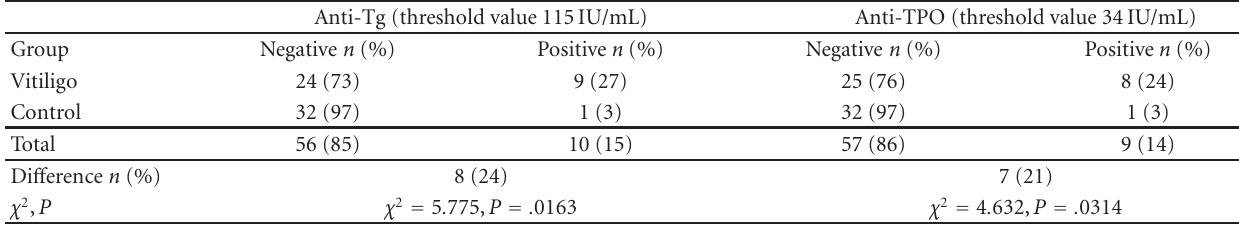
Table 3: Frequency of thyroid autoantibodies in the study